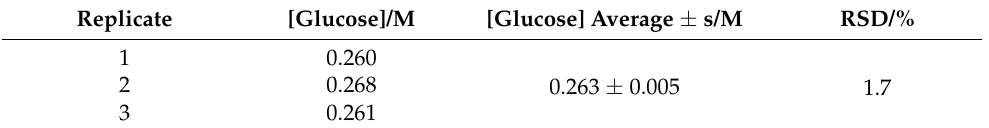
Table 4. Study of the system repeatability. Measurements were performed on the same day using the